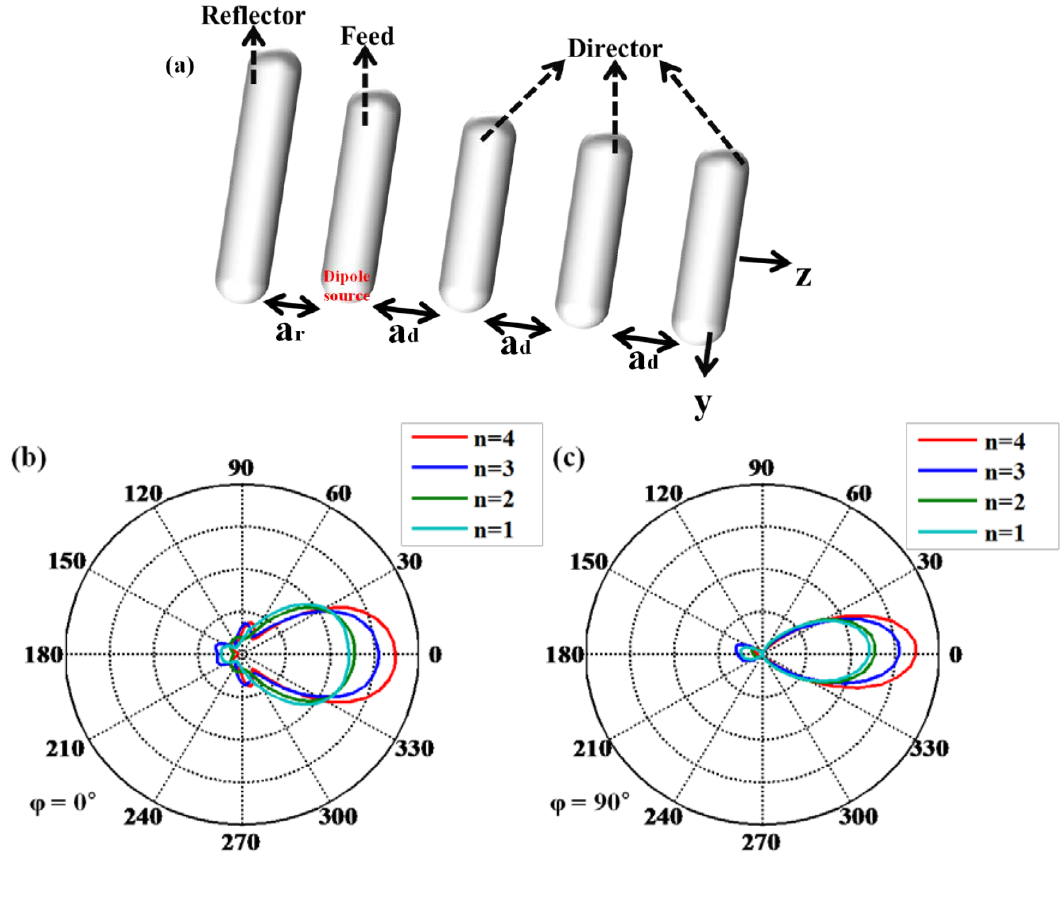
Figure 12. (a) Schematic of optical Yagi-Uda antenna. Feed length of optical Yagi-Uda antenna, wavelength of source, parameters a and 143 nm, respectively. Polar radiation patterns with respect to the number n of